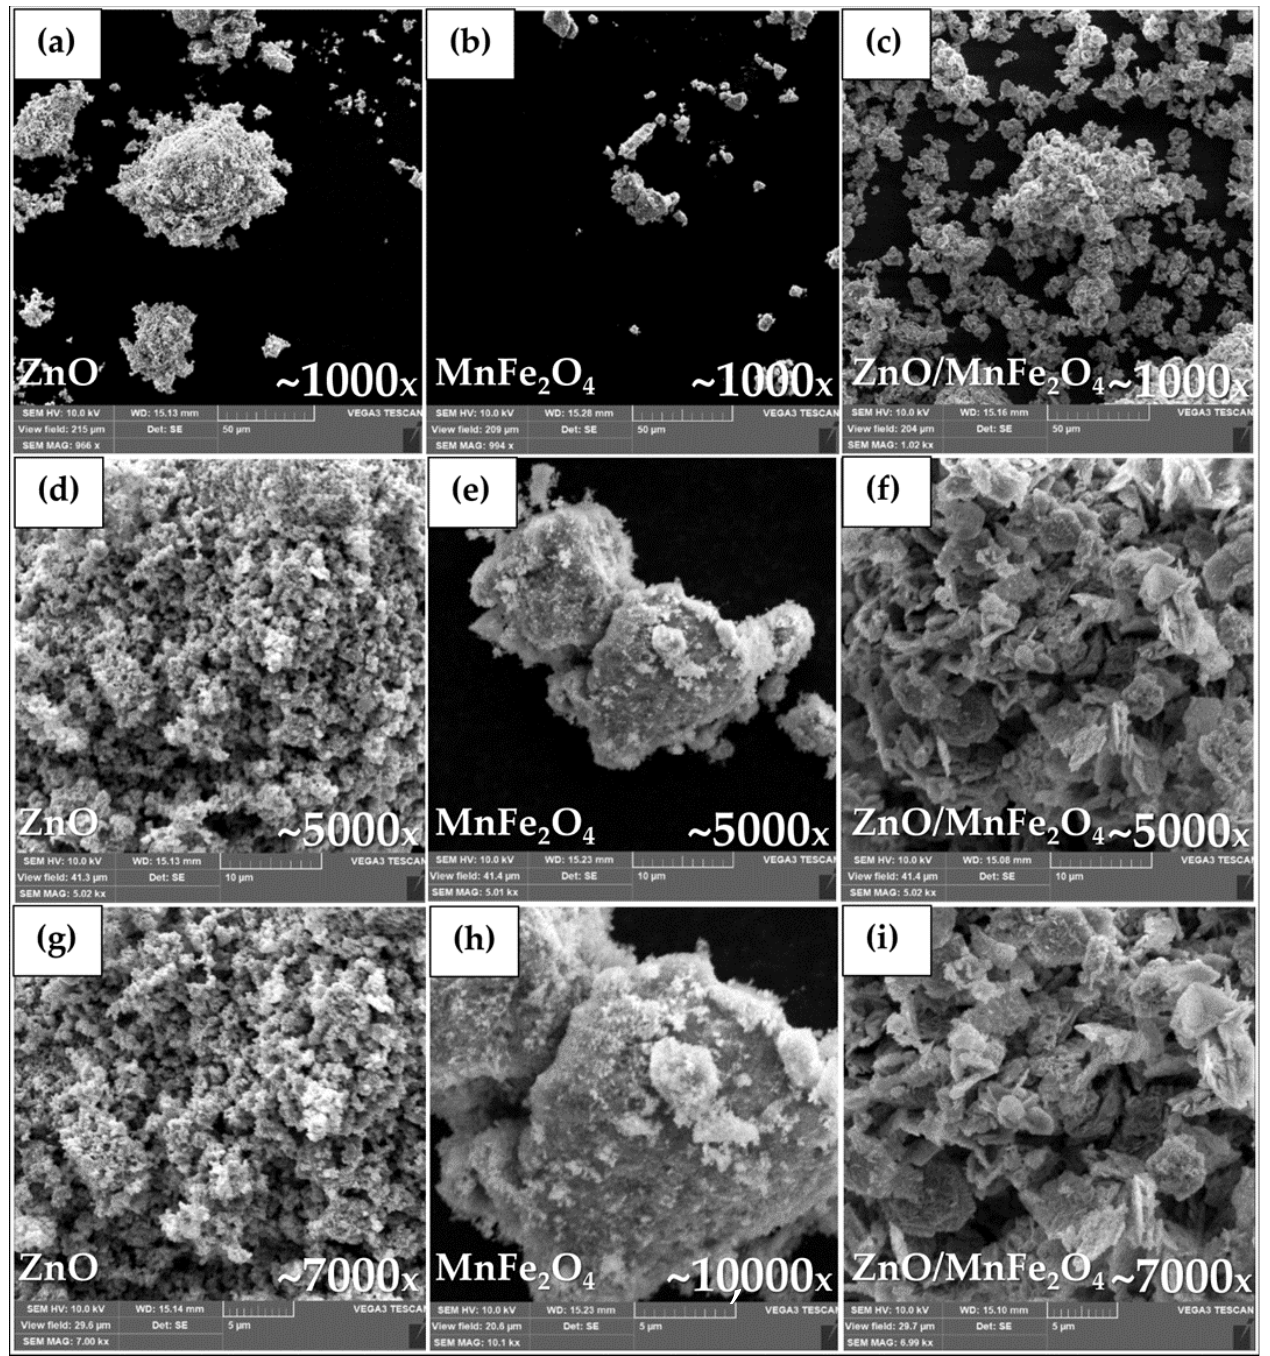
, Figure 2. Micrographs (SEM) of ( a ) ZnO~1000 × , ( b ) MnFe 2 O 4 ~1000 × , ( c ) ZnO/MnFe 2 O 4 ~1000 × , ( d ) ZnO~5000 × , ( e ) MnFe 2 O 4 ~5000 × , ( f ) ZnO/MnFe 2 O 4 ~5000 × , ( g ) ZnO~7000 × , ( h ) MnFe 2 O 4 ~10,000 × , ( i ) ZnO/MnFe 2 O 4 ~7000 ×